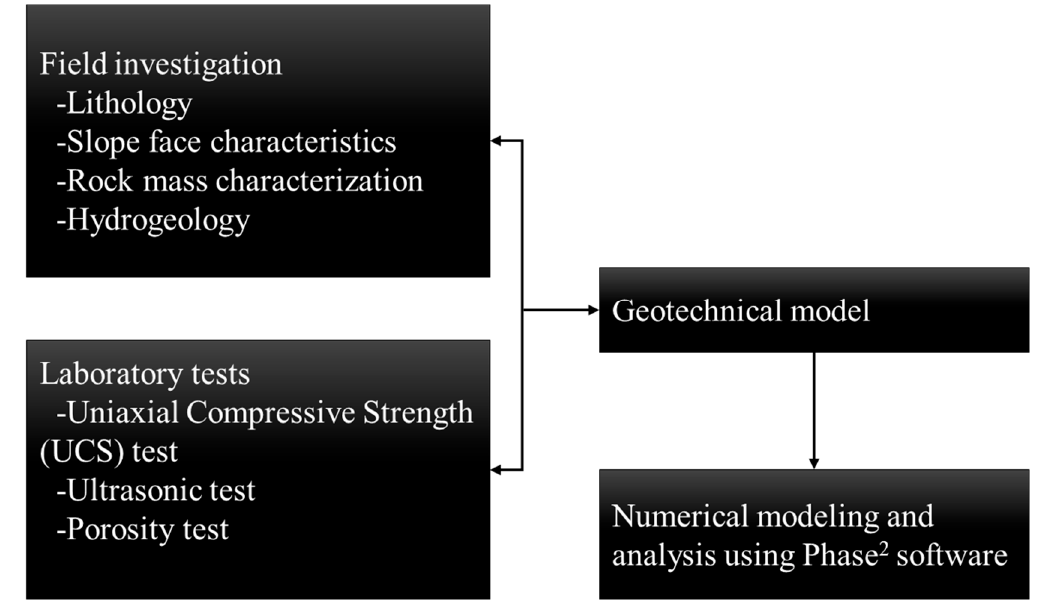
Figure 3. The workflow process.